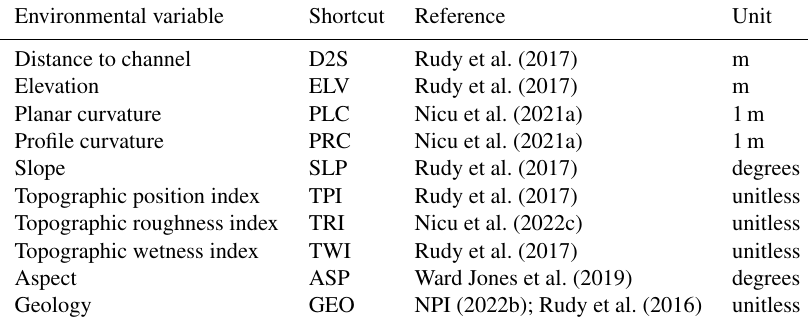
Table 1. Environmental variables used in the